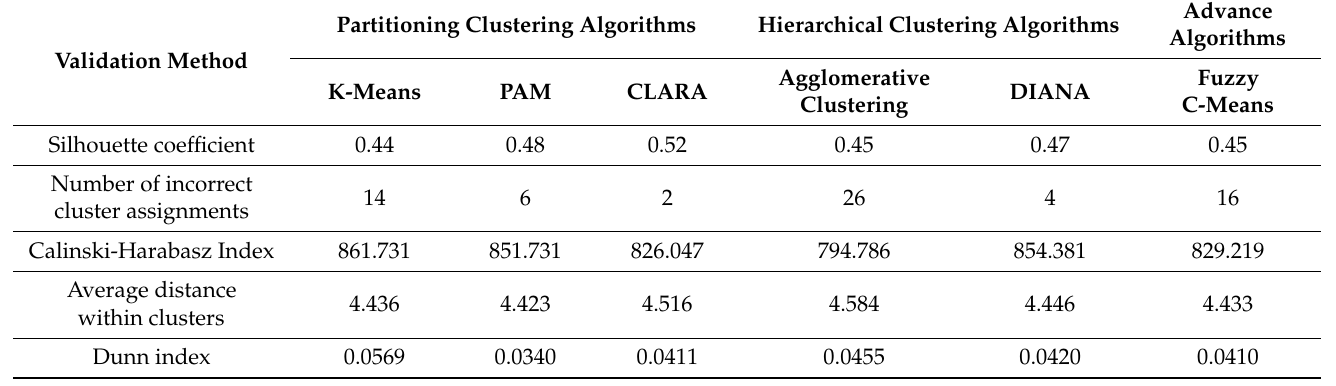
Table 6. Validation result for the various clustering